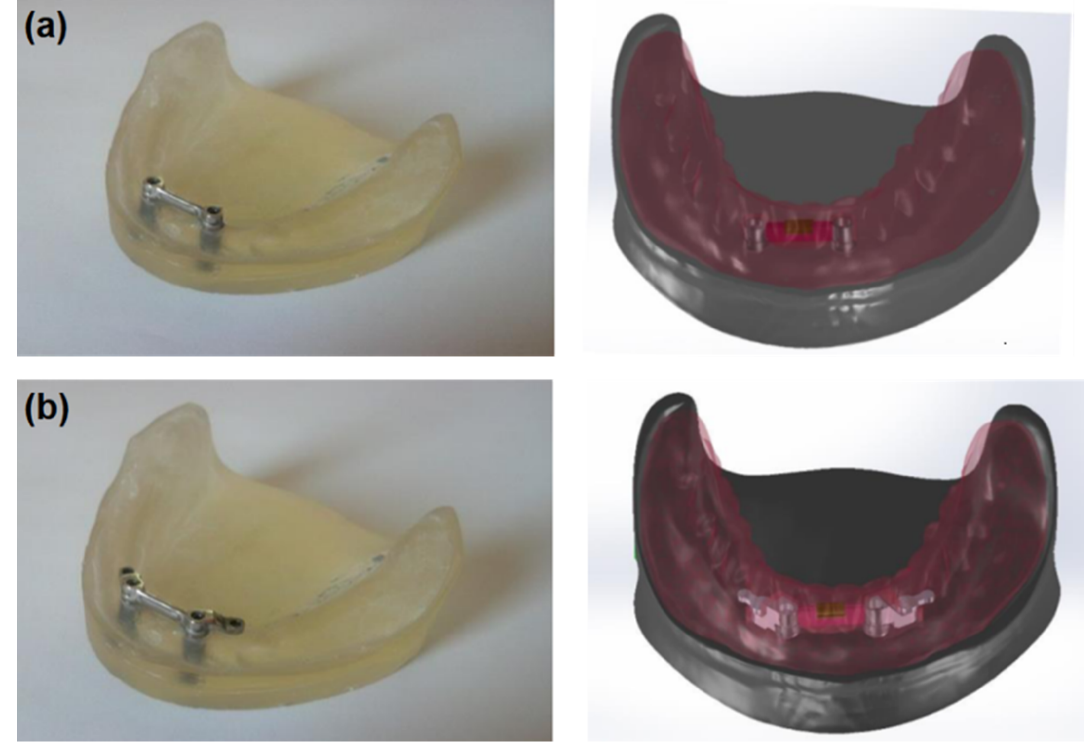
Materials 2021 , 14 , x FOR PEER REVIEW Figure 1. A real model and a computer model ( a ) of the first studied system and ( b ) of the second studied system.